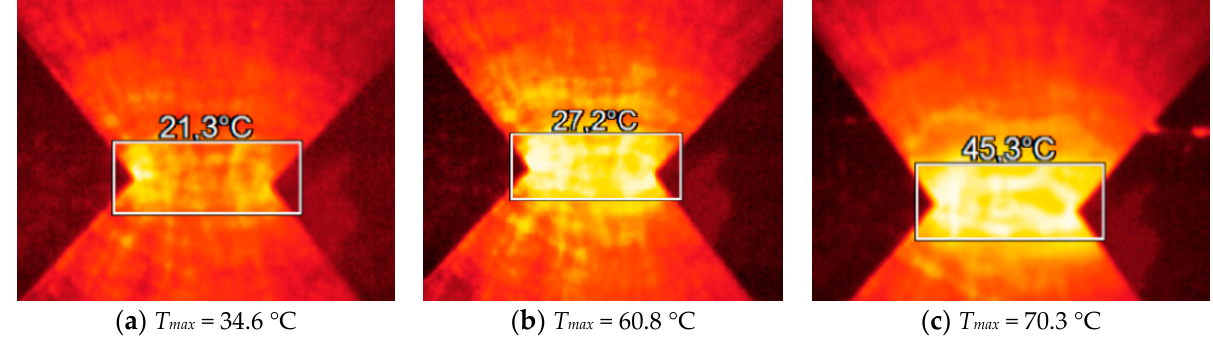
Figure 16. Examples of temperature distribution evolution obtained with the IR camera in the dry band formation zone for an applied voltage of 2 kV and for an average ESDD of 1.34 mg/cm 2 , where the maximum temperature T max obtained inside the rectangular highlight zone is equal to ( a ) 34.6 °C at t = 0 s, ( b ) 60.8 °C and ( c ) 70.3 °C.